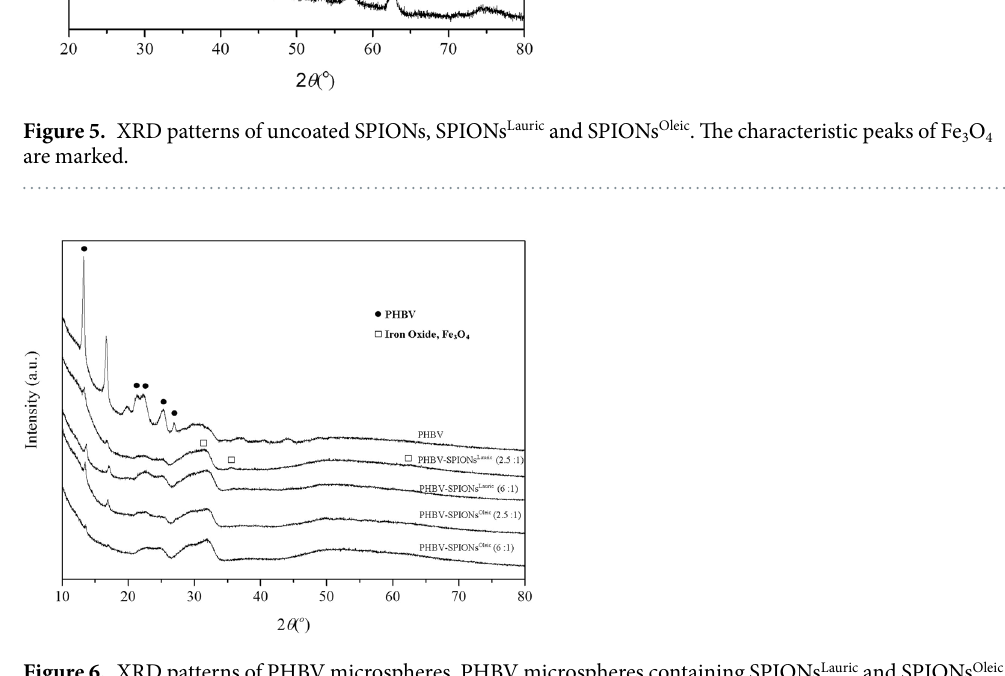
Figure 6. XRD patterns of PHBV microspheres, PHBV microspheres containing SPIONs Lauric and SPIONs Oleic .